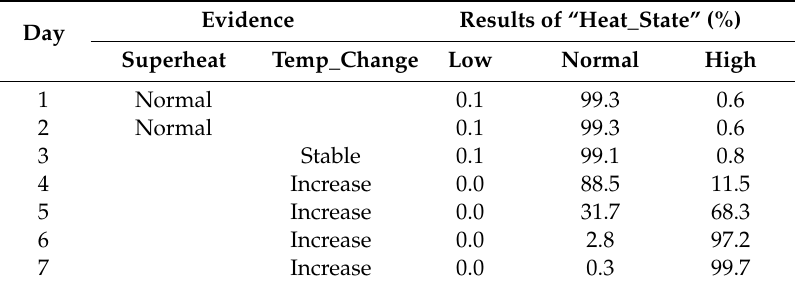
Table 4. Evidence and results of continuous calculation for Case A.